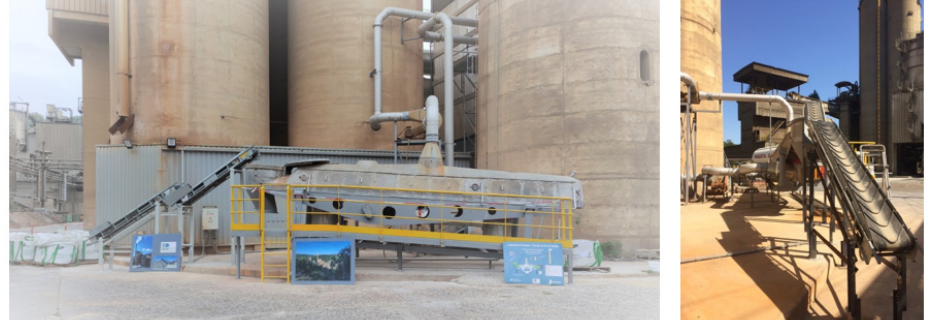
Figure 5. Fluidized bed at the LafargeHolcim Val d’Azergues cement plant.